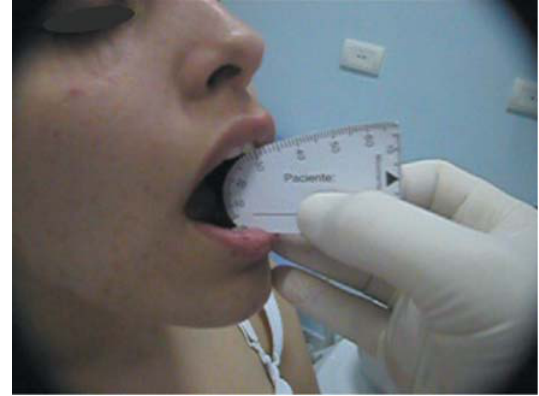
FIGURE 1- limitation of mouth opening and jaw movement with deviation to the right